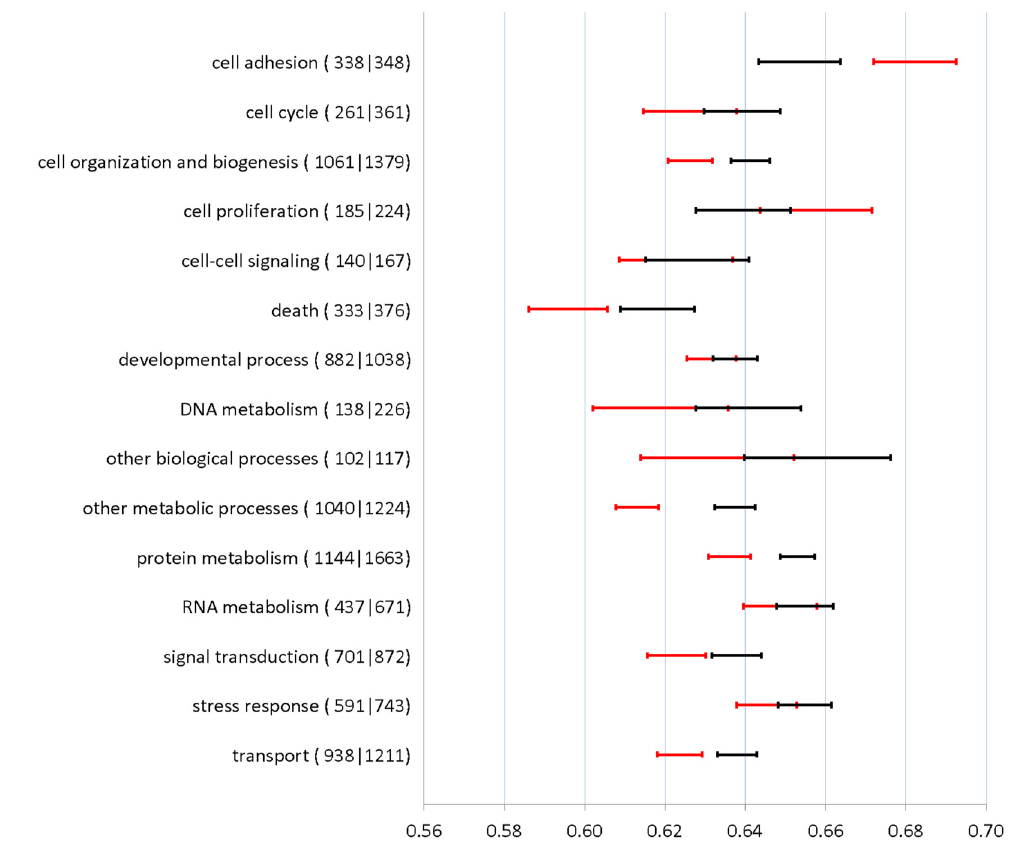
Fig 2. Differential methylation (measured by CpG o/e ratio) in gravid females that produce planktonic or benthic larvae. The numbers of ORF containing contigs in each GO Slim category are shown in parenthesis after category name (benthic | planktonic: total 8658). Bars represent mean CpG o/e ratio for ORF containing contigs in each GO Slim category ± 1 standard error of the mean (planktonic, black; benthic,